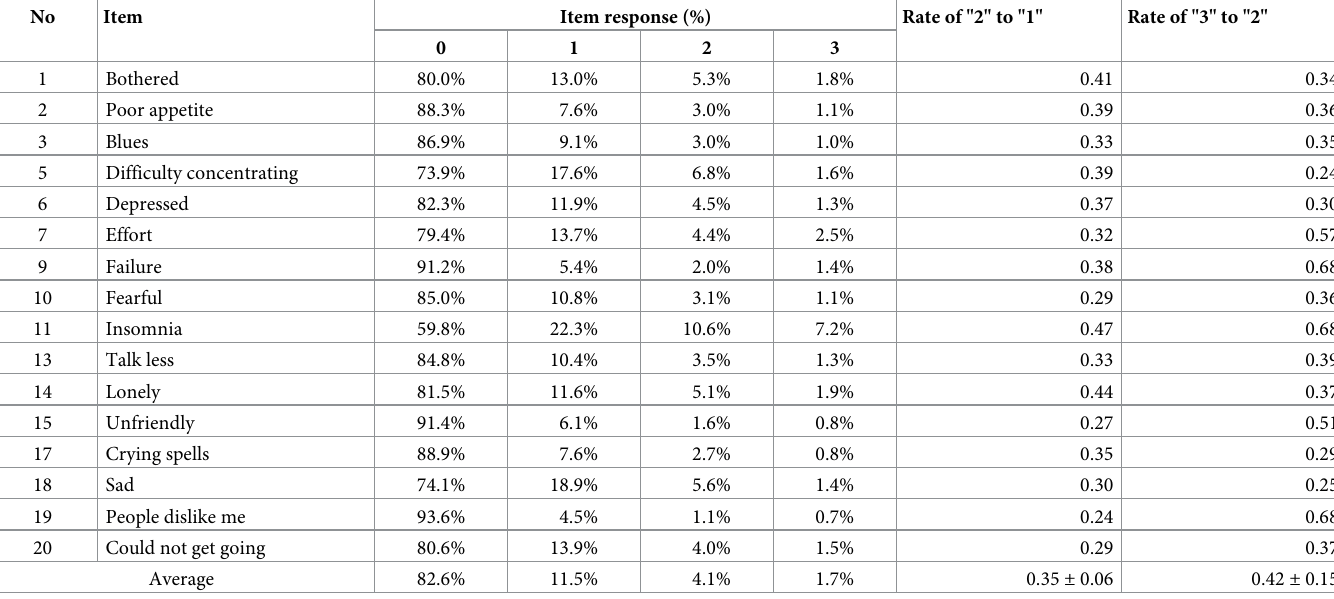
Table 1. Center for Epidemiologic Studies Depression Scale (CES-D) item